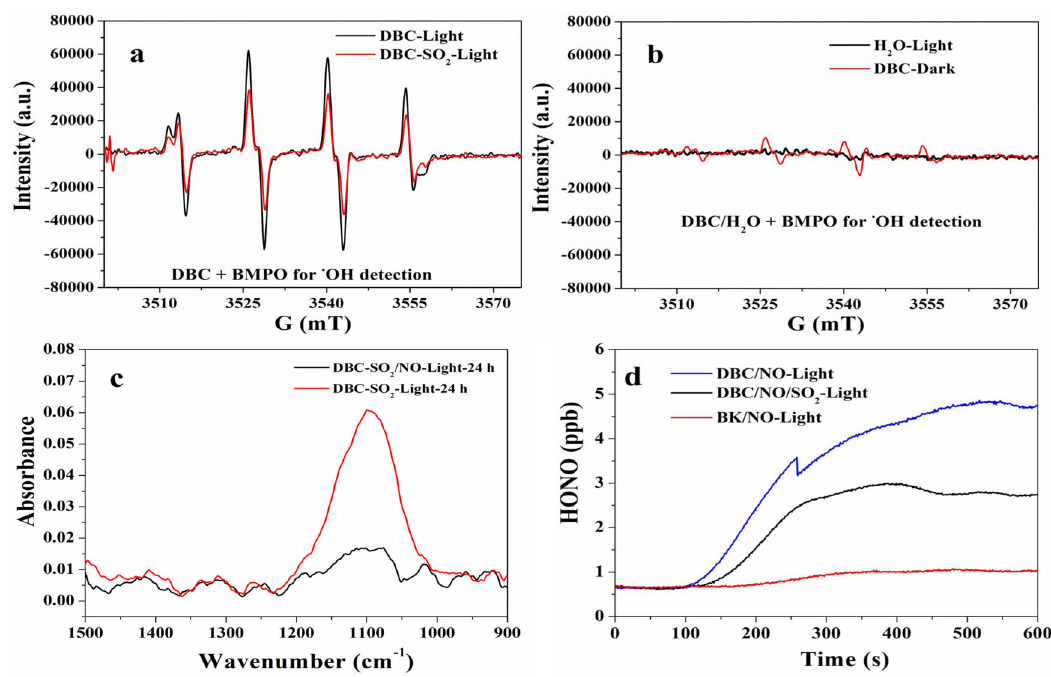
irradiation ( b ). Comparison of in-situ DRIFTS spectrum of sulfate in the absence and presenceof10ppmNO( c ).The heterogeneousconversion ofNO(168ppb) to HONO under different conditions ( d